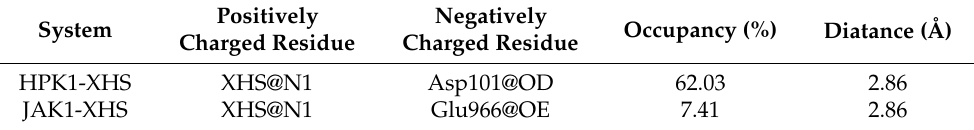
Table 3. Salt bridge interaction between the inhibitors and kinases